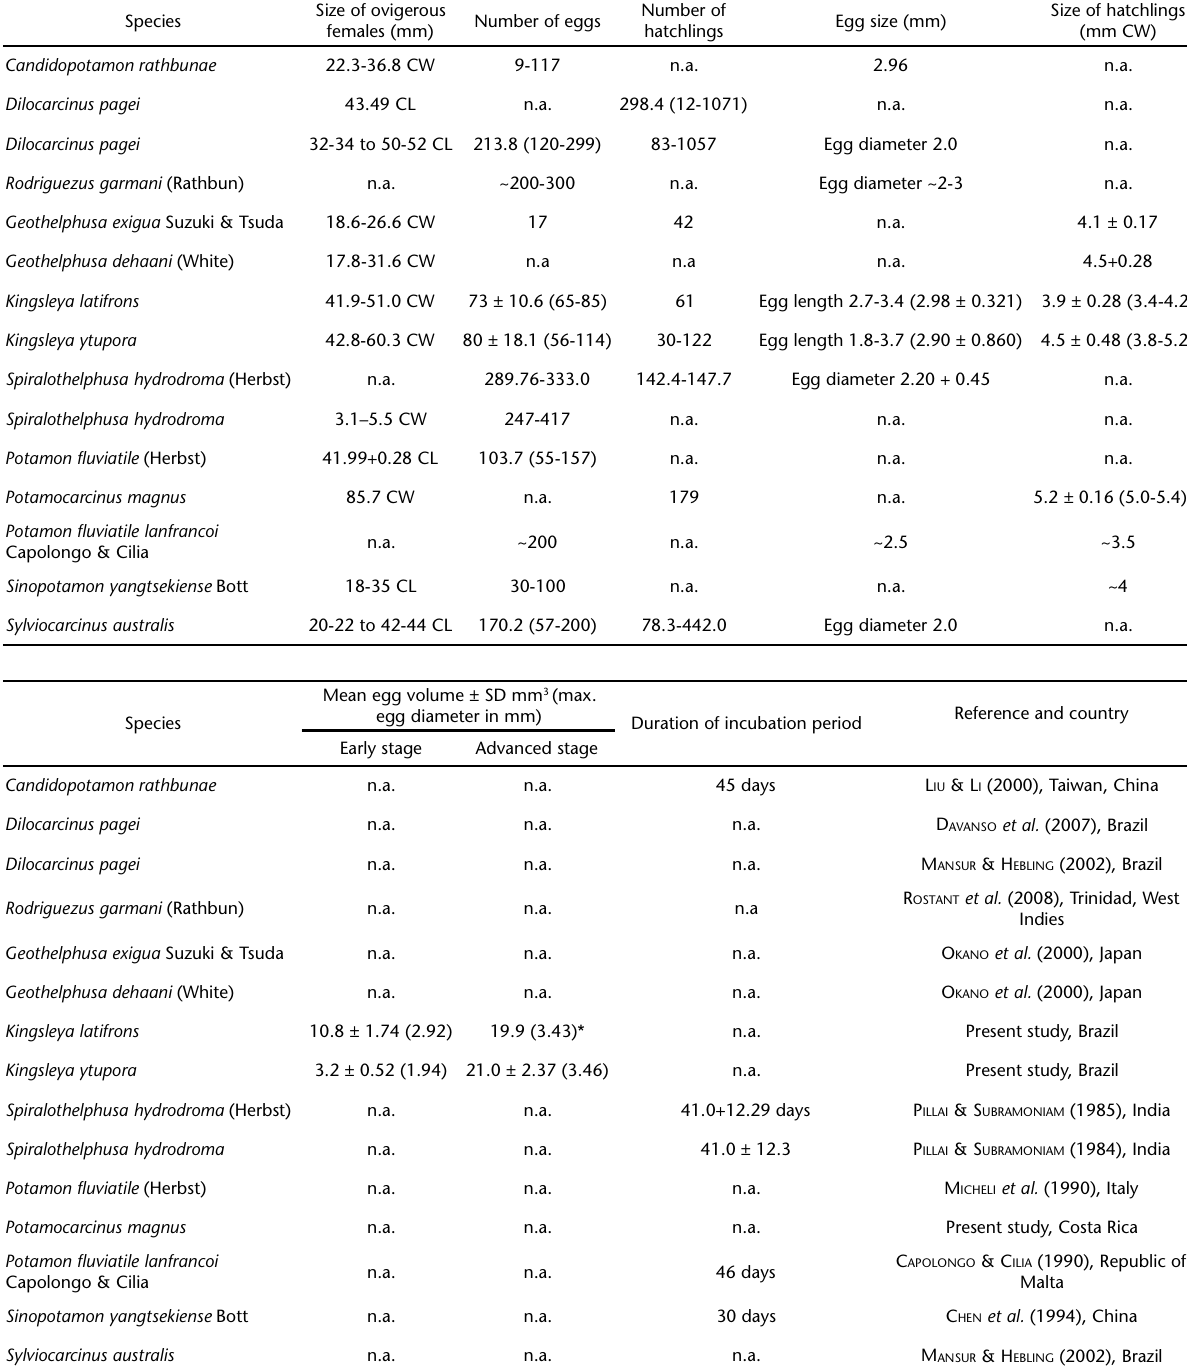
Table I. Comparison of reproductive features in freshwater crabs (n.a. = information not indicated in the cited publication; CL = carapace length; CW = carapace width). Egg size (egg length or egg diameter, otherwise not specified in the study) refers to eggs independent of their developmental